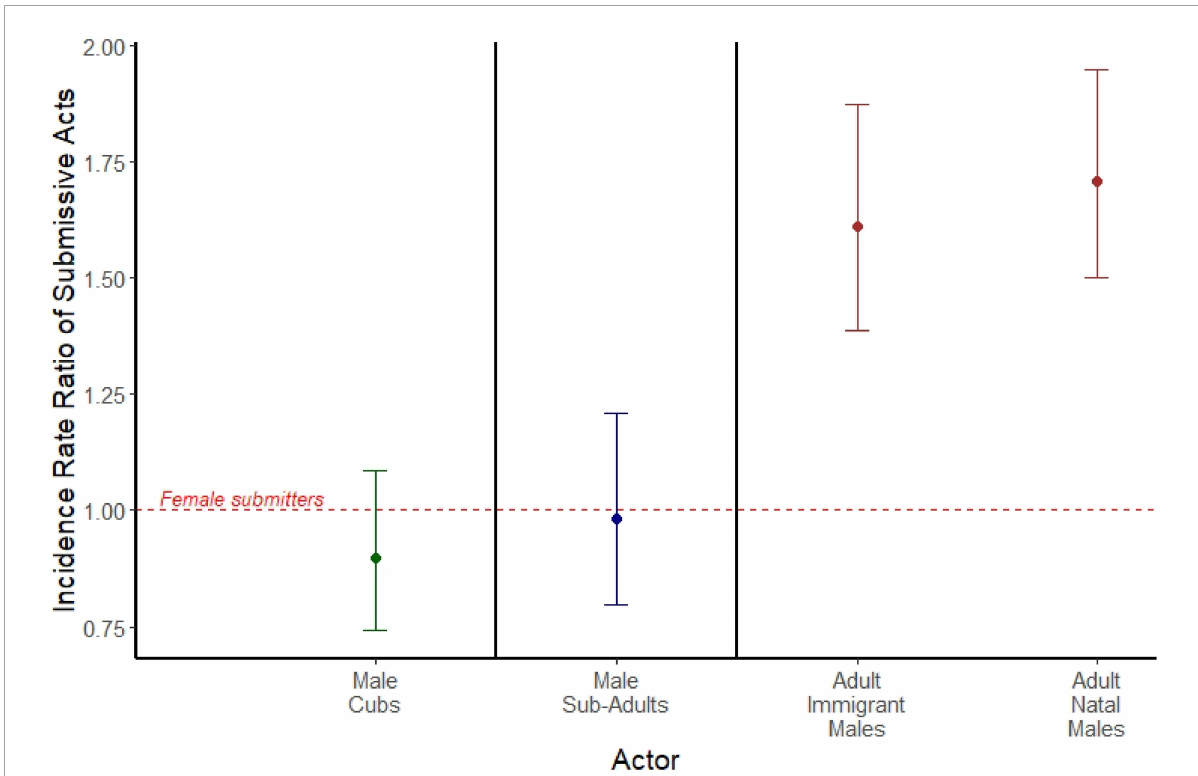
FIGURE2 Incidence rate ratios of spontaneous submissive acts emitted by male cubs (green), male subadults (blue), adult immigrant males (brown), and adult natal males (brown). Each is compared to a female actor reference group of the same age class, represented by the red dashed line. Points represent the estimated incidence rate ratios from three separate mixed models separated by bold black lines (actors who are cubs, actors who are subadults, and actors who are adults), and error bars represent 95% confidence intervals around the incidence rate